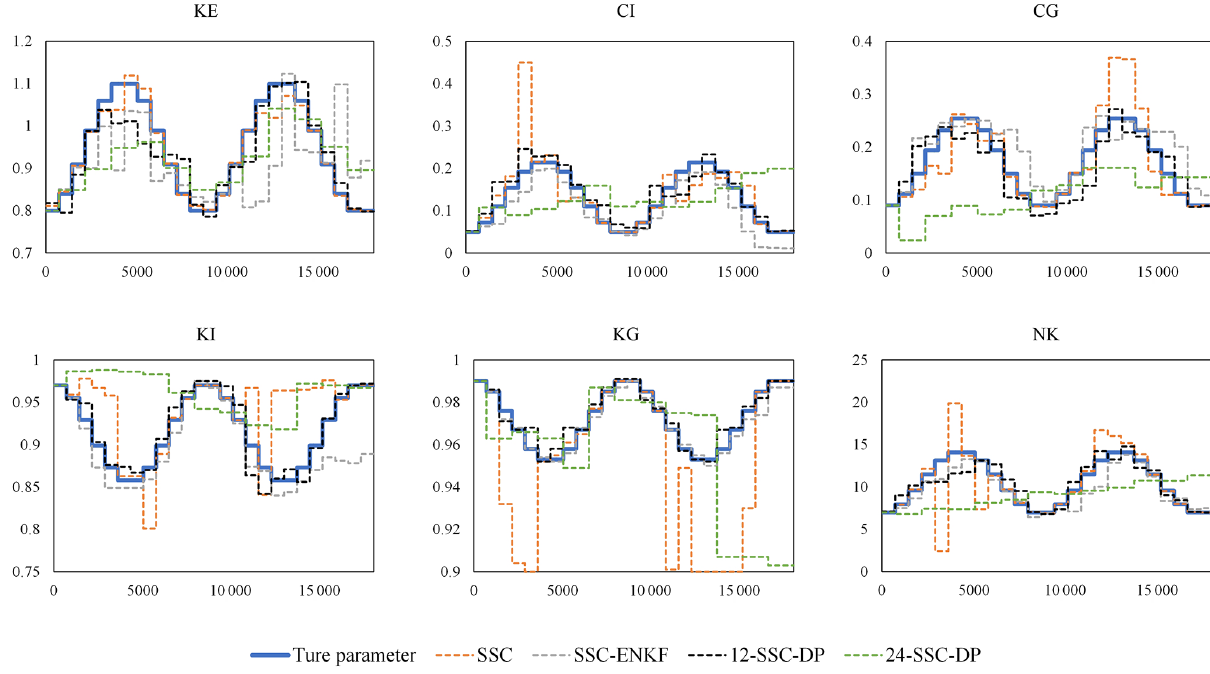
Figure 10. Comparison between estimated parameters and their true values for scenario 3 of the synthetic experiment with the Xinanjiang model.